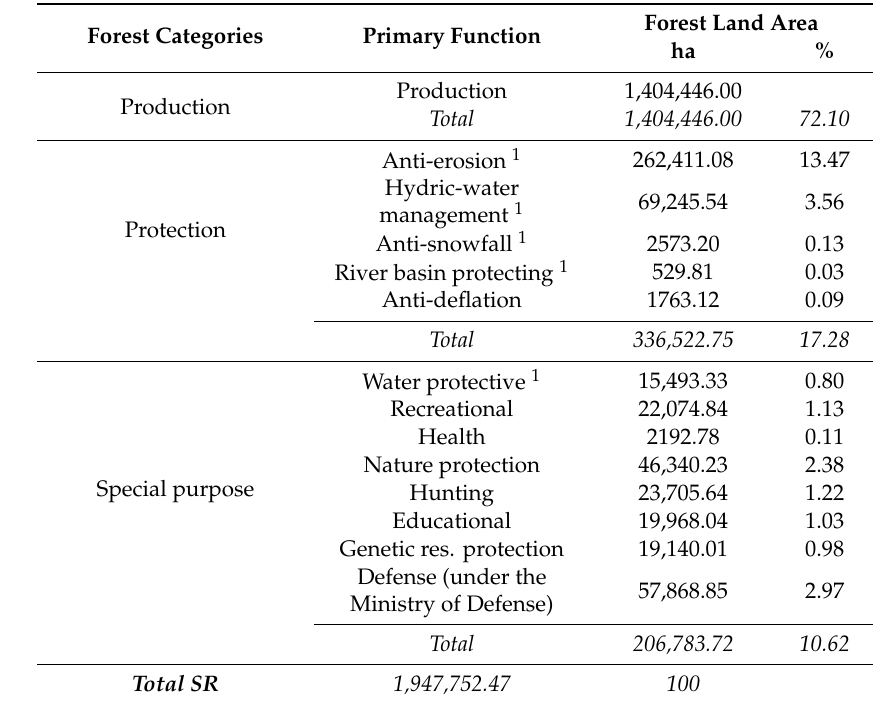
Table 5. The forest categories in